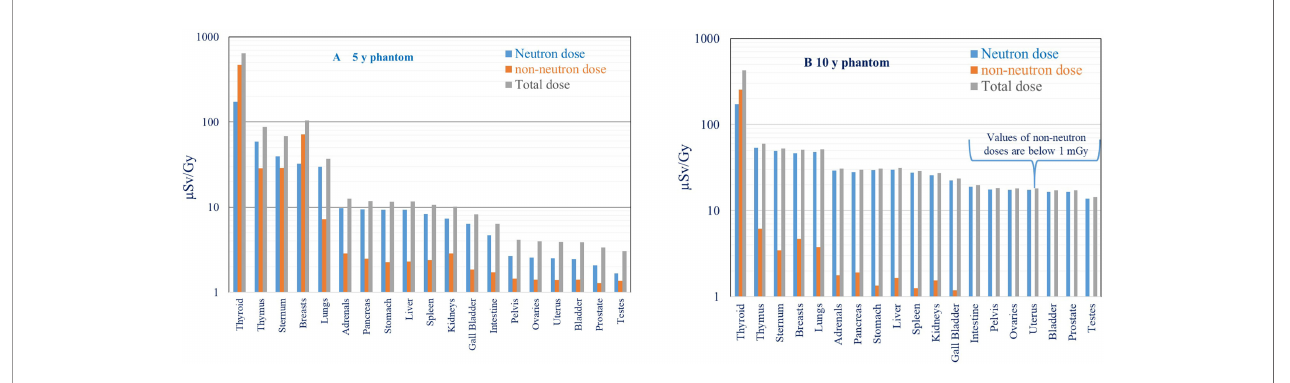
FIGURE 7 | (A, B) Comparison of neutron, non-neutron, and total equivalent organ doses (µSv/Gy) for 5- (A) and 10-year-old (B)